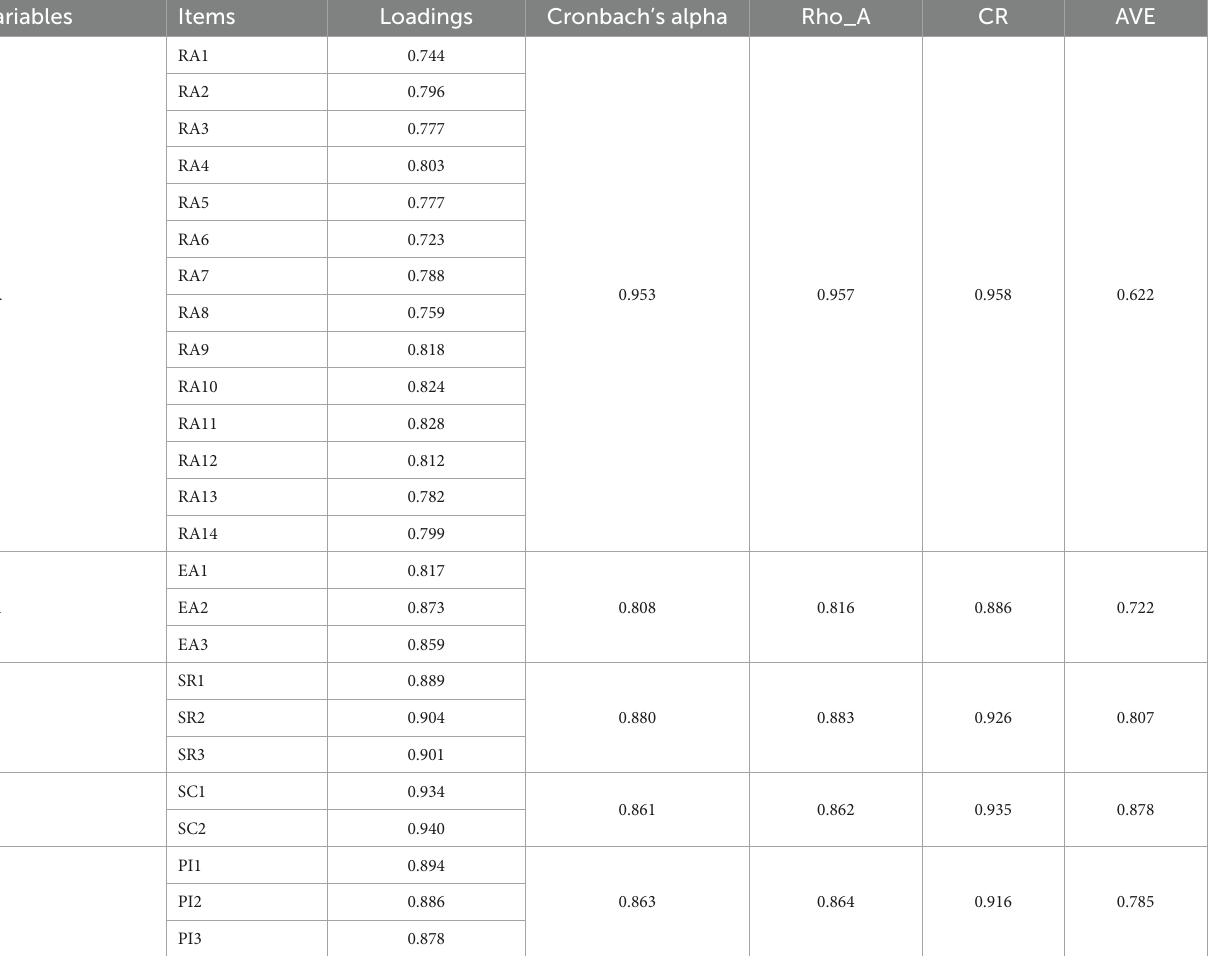
TABLE 3 Reliability and validity results of measurement model.